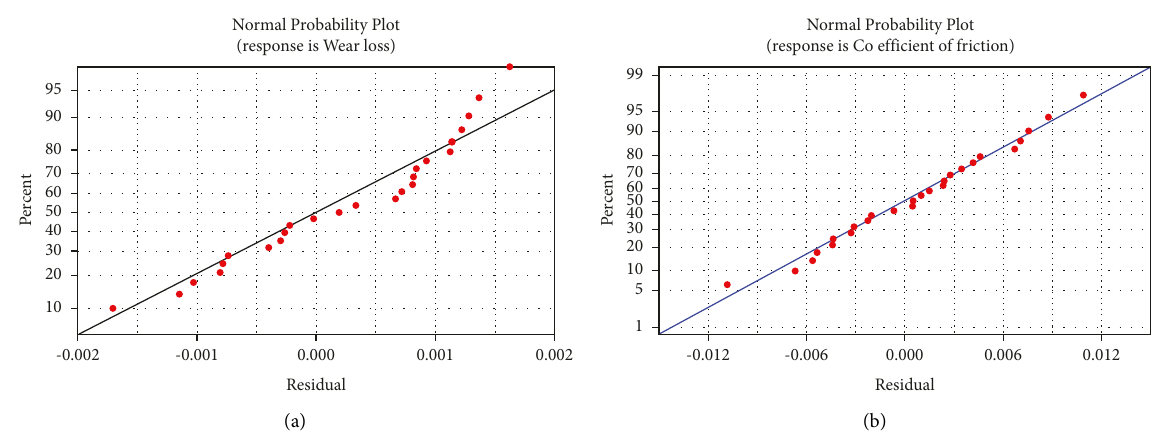
Figure 7: Standard probability plot. (a) Wear loss. (b) Coefficient of